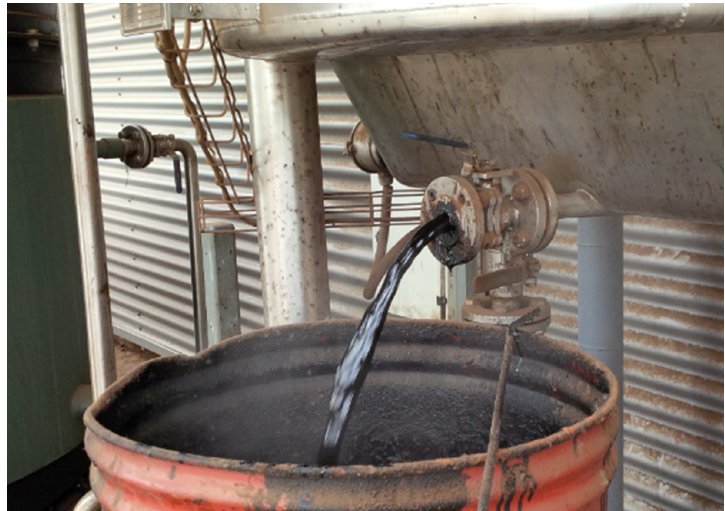
Figure 7. Liquid fraction made up mostly of water. Despite being a product with low calorific value, its valorization allows the reduction of the energy costs of the process, at the same time that it allows the elimination of products that cannot be simply emitted into the atmosphere or dumped in the public domain.